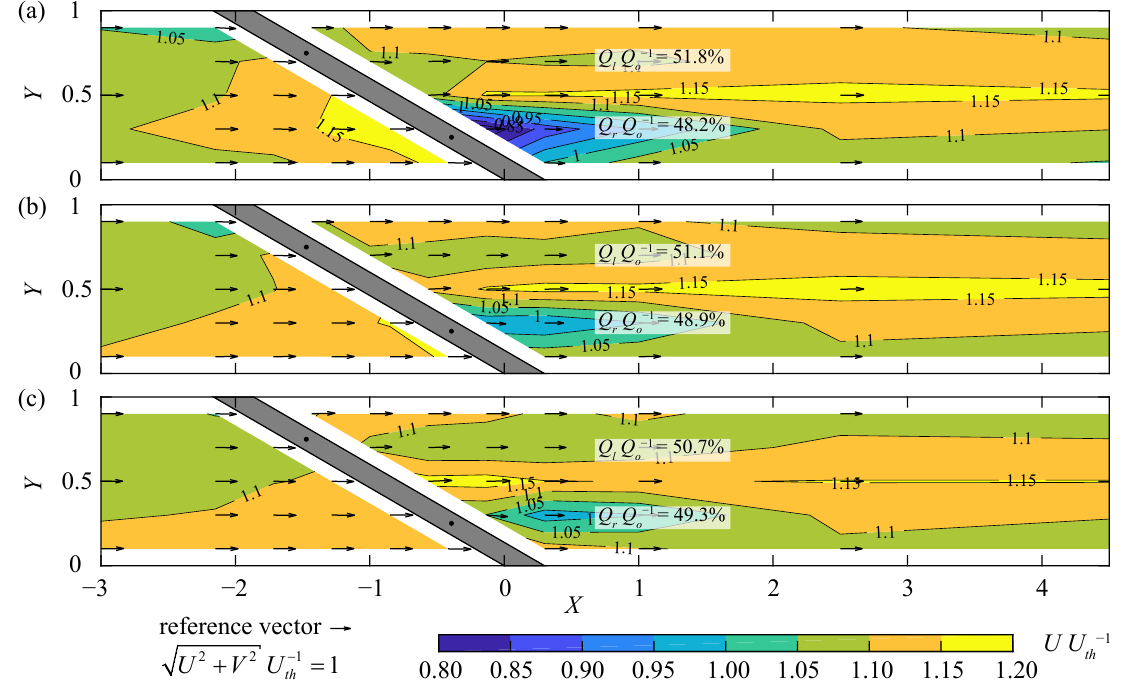
Figure 7. Velocity field at Z = 0.5 for S4, α = 30 ◦ , and H Ov = 0 for ( a ) s b = 10 mm ( ξ R = 0.38), ( b ) s b = 20 mm ( ξ R = 0.23), and ( c ) s b = 30 mm ( ξ R =